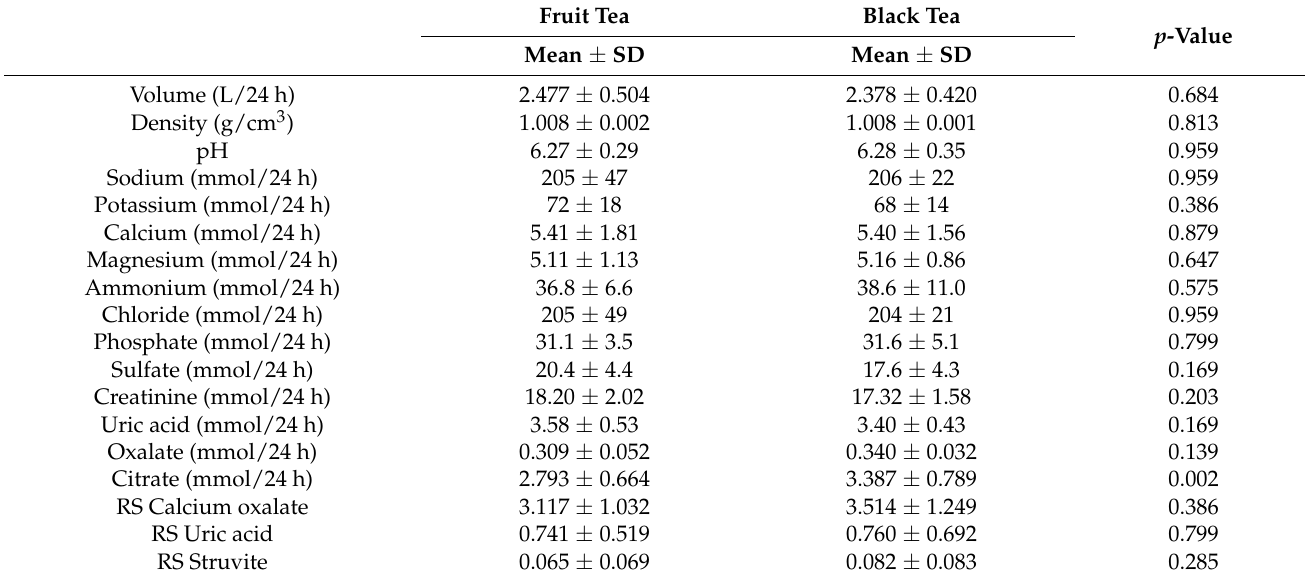
Abbreviations: RS, relative supersaturation; SD, standard